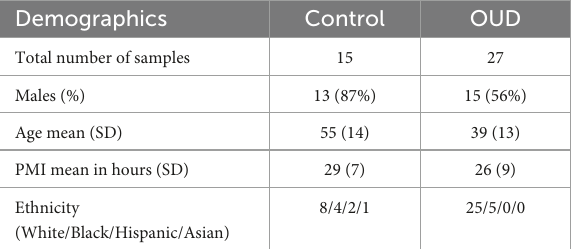
TABLE 1 Demographic information of samples used for RNA-sequencing and smallRNA-sequencing.